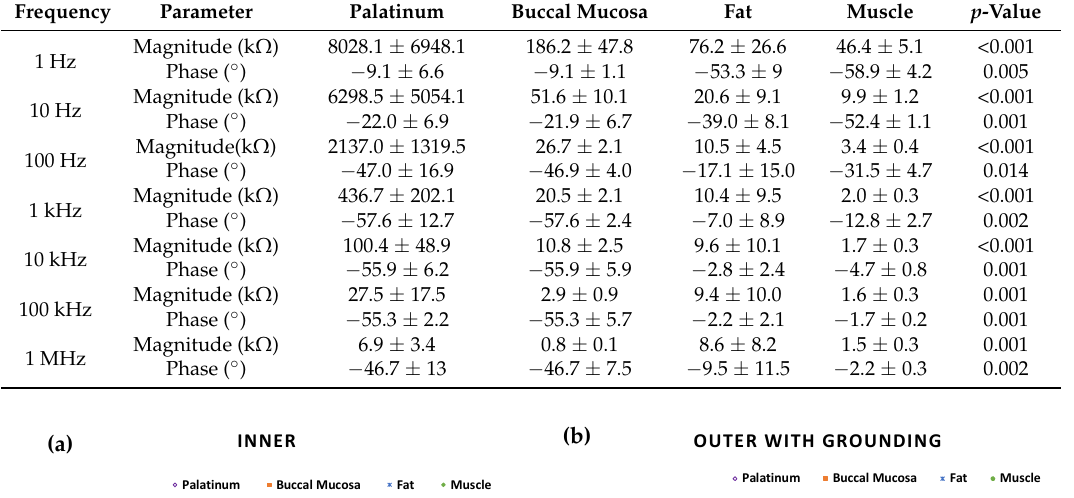
Table 2. Impedance magnitude and phase values (mean ± stdv) for each tissue type at seven discrete frequencies using the outer with grounding configuration. The p -value was calculated using the Kruskal-Wallis test.